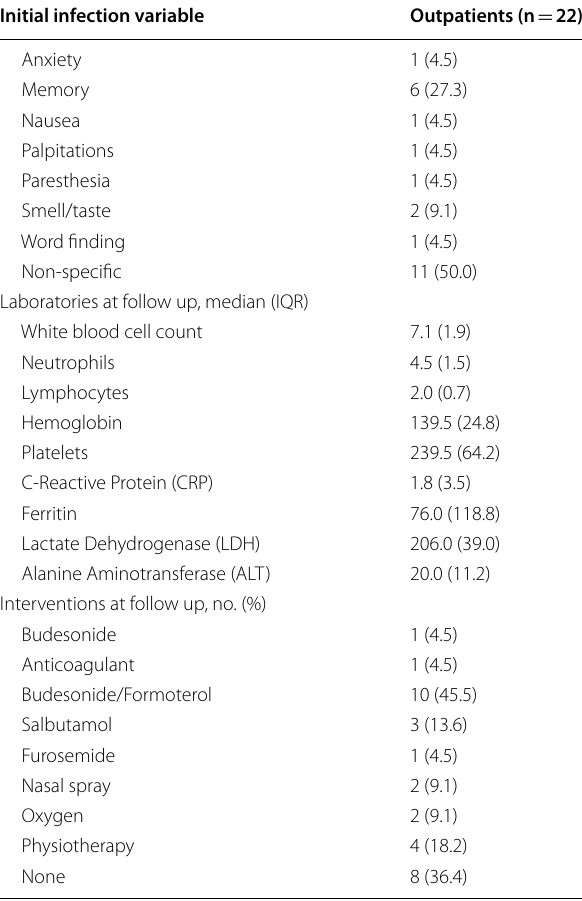
Table 1 Long-COVID outpatient demographics and clinical